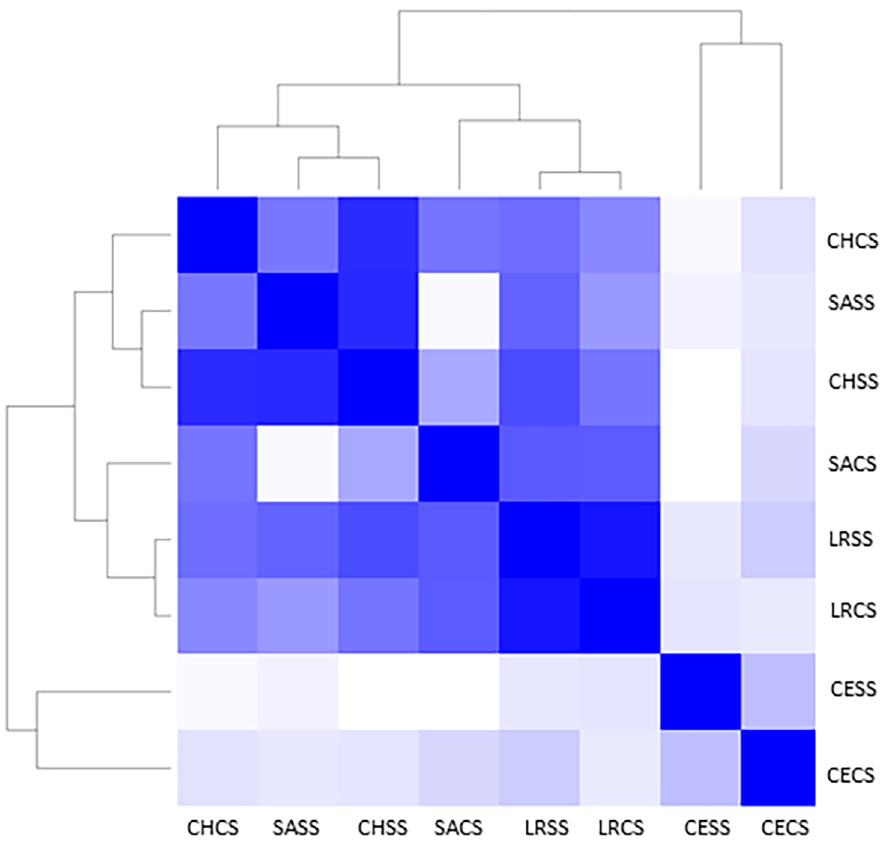
conditions: tryptone soy + 3% NaCl (CS) and tryptone soya